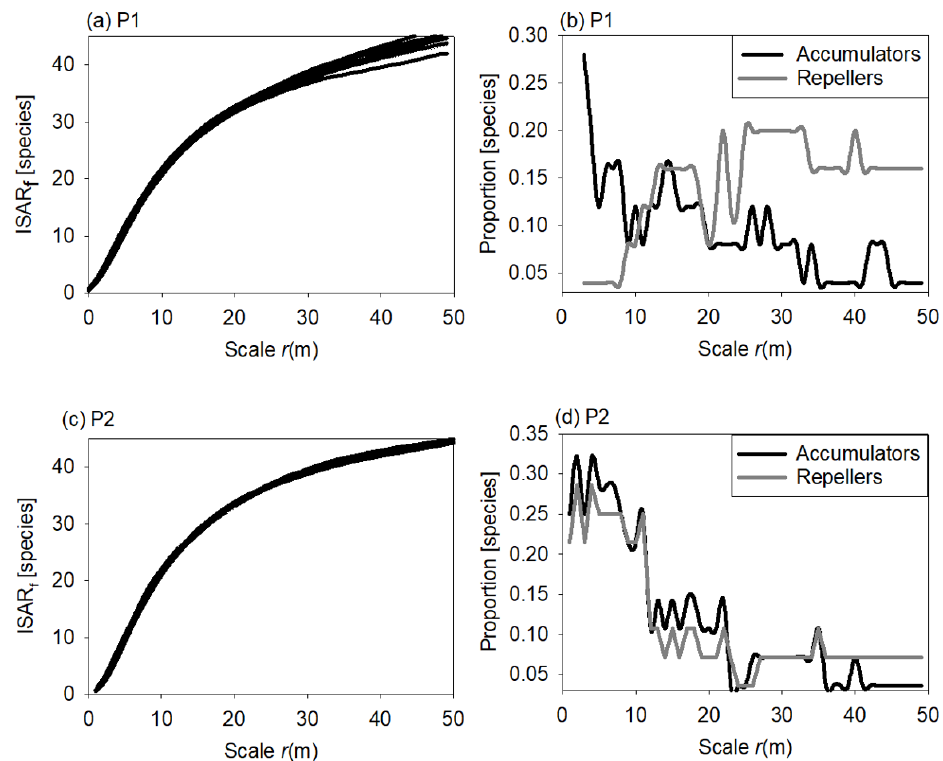
Figure 4. Results of ISAR analyses from 199 Monte Carlo simulations under null models of CSR in P1 ( a – b ) and IPP in P2 ( c – d ); significant at p ≤